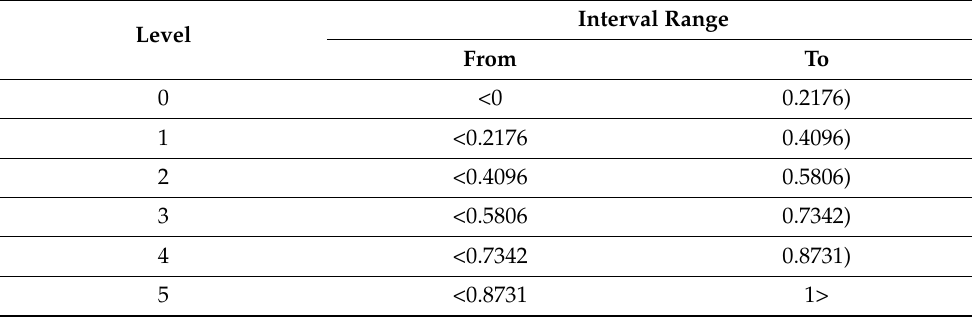
Table 7. Interval ranges and corresponding